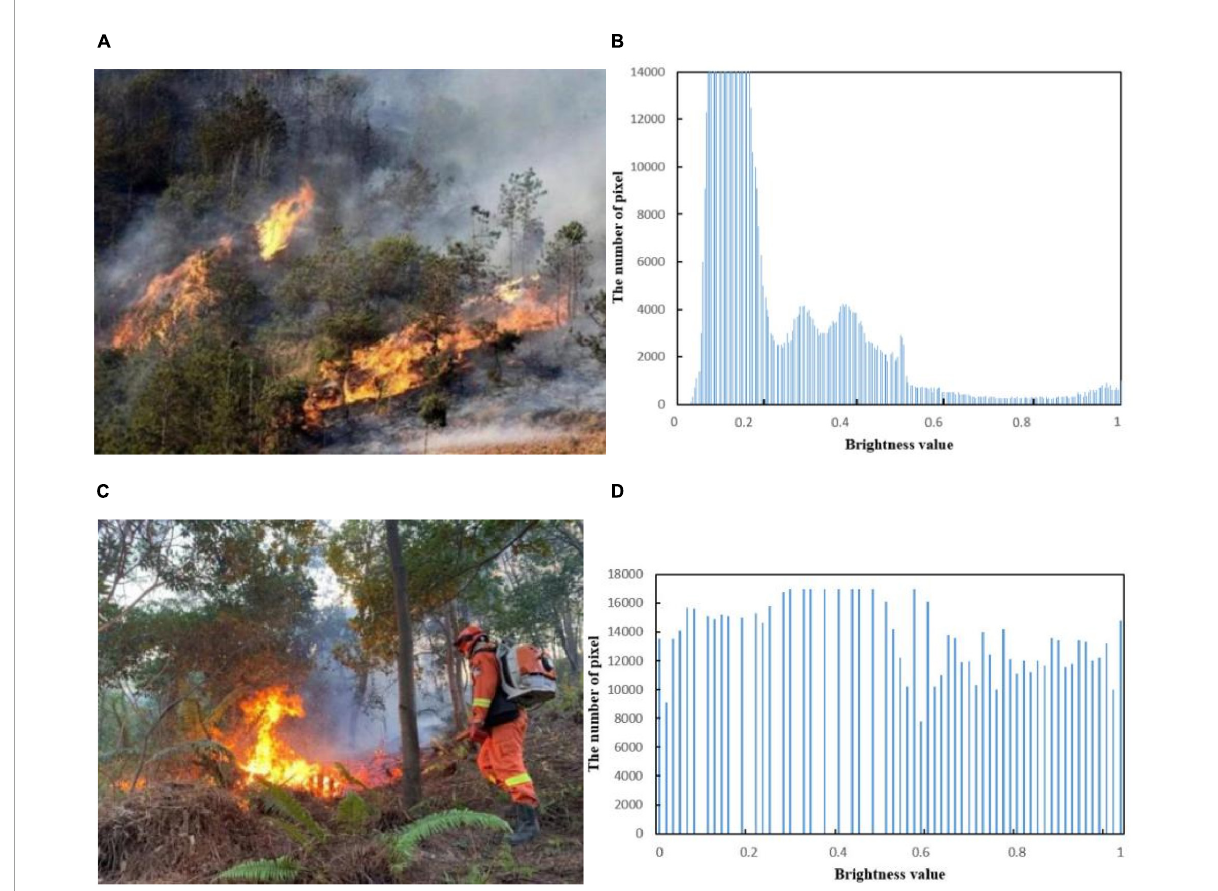
FIGURE8 Flame brightness value: (A) Original image 1, (B) image 1 brightness value, (C) original image 2, and (D) image 2 brightness